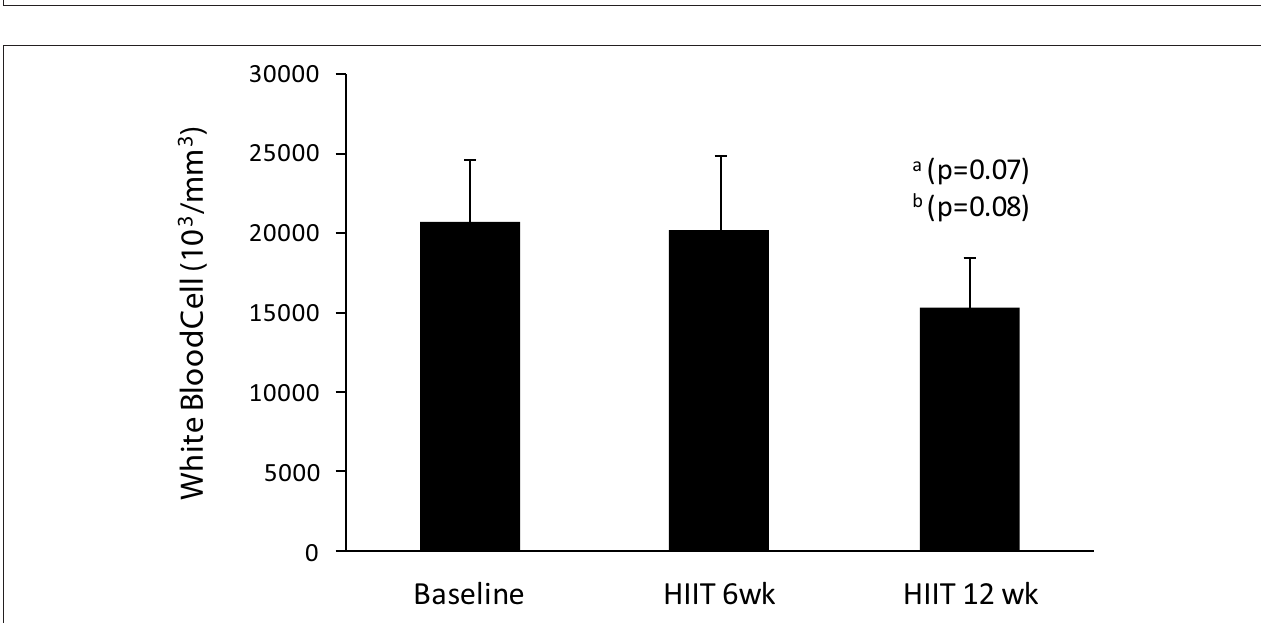
FIGURE 4 | Percentage differences in creatinine, uric acid, and urea when compared to respective CT group. Data labels are presented in mean ± standard deviation (creatinine = mg/dL; uric acid = mg/dL; urea = mg/dL).